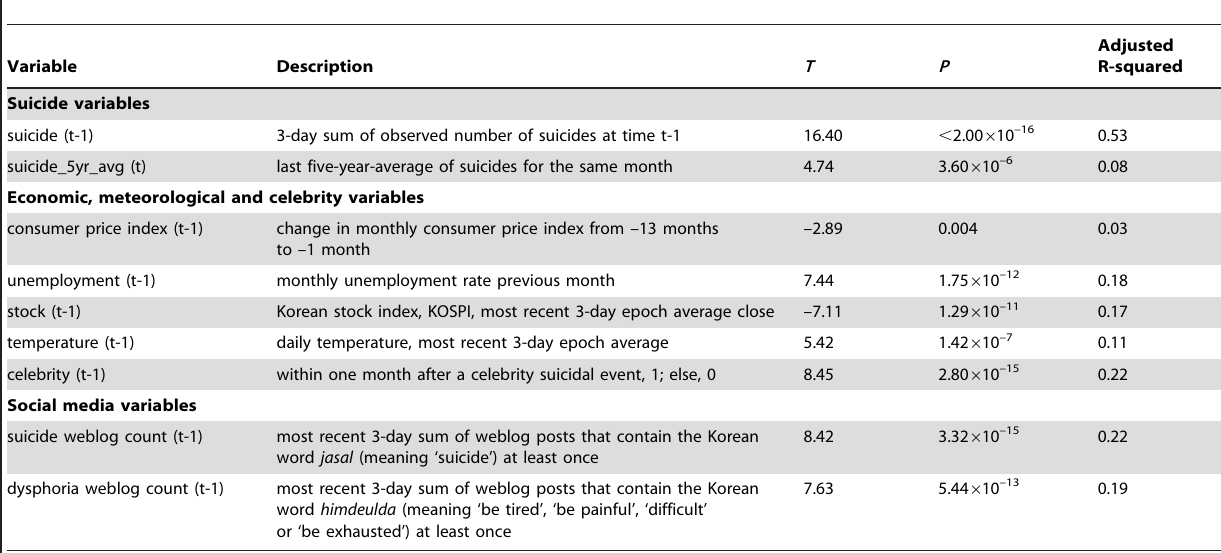
Table 1. Variables selected for multivariate prediction model development.